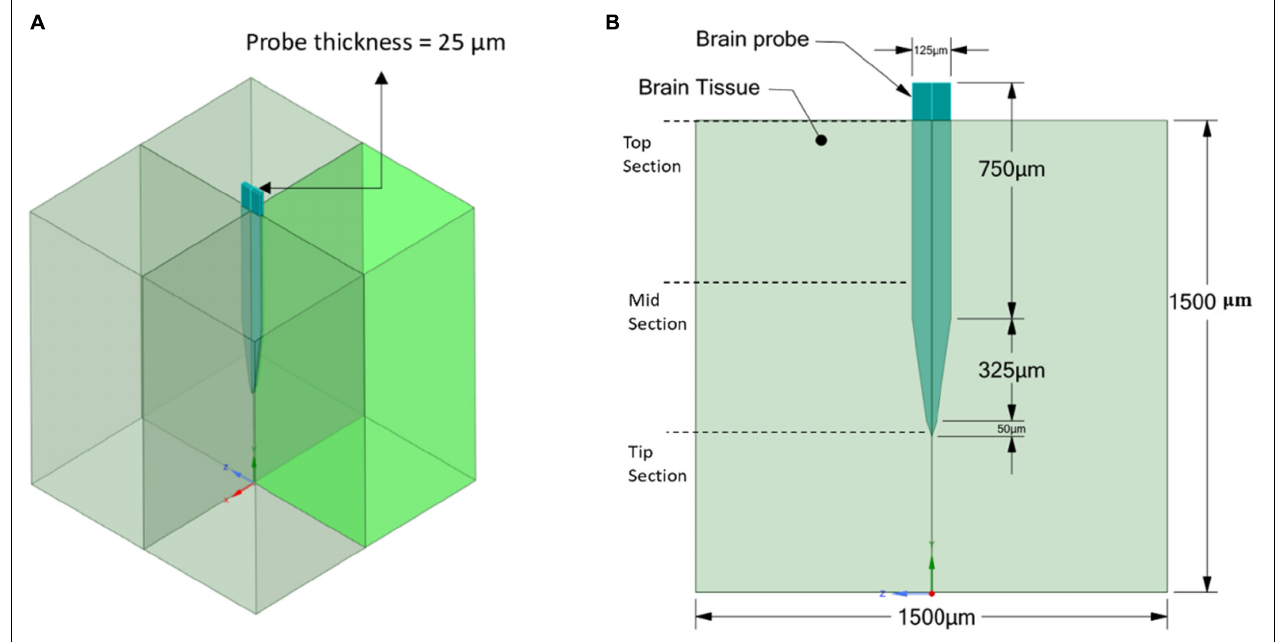
FIGURE 2 | Stiff probe and brain tissue geometrical model and dimensions. (A) 3D view; (B) 2D front view.